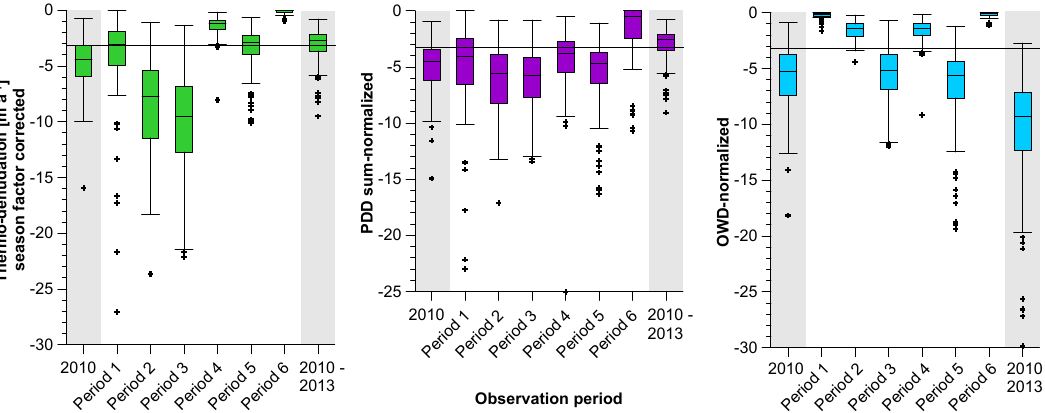
Figure 15. TD rates for eight different time periods: 2010, 1(spring2010), 2(summer2010), 3(summer2010), 4(fall2010), 5(2011–2012), 6(fall 2012–spring 2013), and the entire observation range 2010–2013 (with a mean rate of − 3 . 1 ± 1 . 6ma − 1 included as horizontal reference baseline for current TD). Left series: correction to the length of the TD-active season (number of days with mean T air > 0 ◦ C) during the observation period yield actual TD velocity. Middle: TD rates normalised using PDD sums for each period, which produces roughly comparable rates. Right series: similar normalisation using